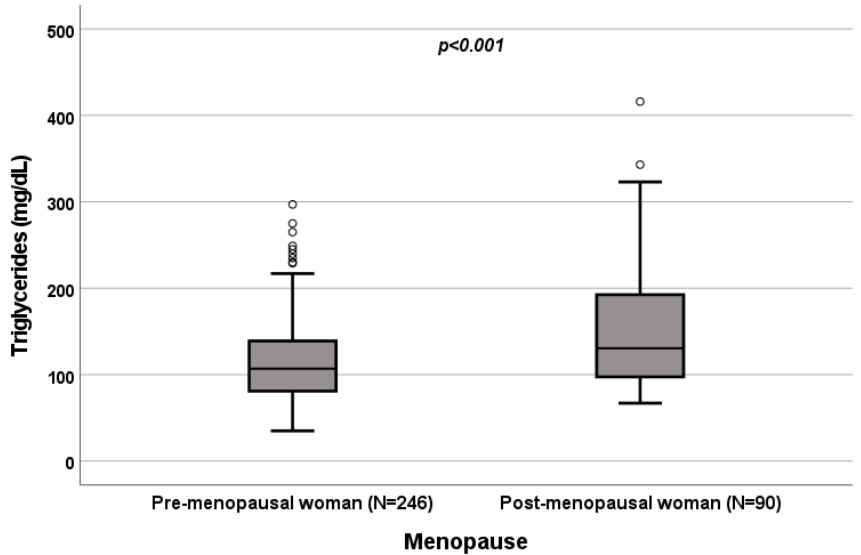
Figure 7. Influence of sex on triglyceride levels (mg/dL). Box plot of sex’s influence on triglyceride levels (mg/dL): The black lines in the boxes showed the interquartile ranges (IQRs): quartile 1, median values and quartile 3; the open dots and stars describe the outlier values. The P- value is shown.